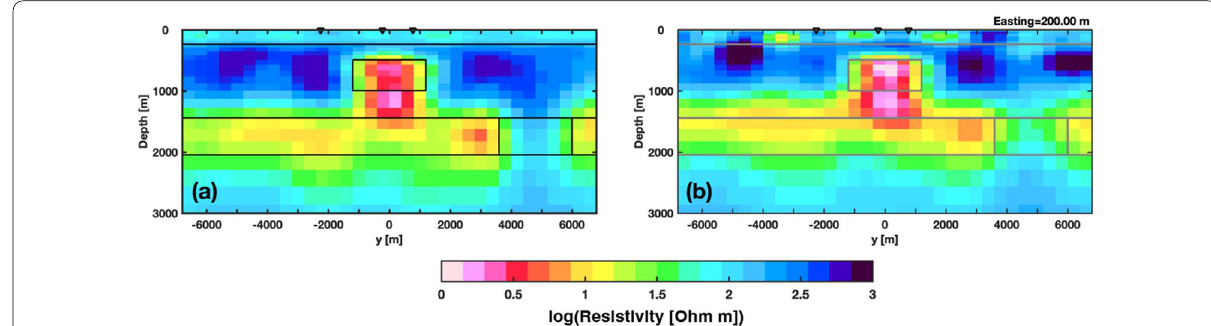
Fig. 30 NS cross sections at the easting of 200 m of the models inverted from a the synthetic model (Fig. 1) and b the synthetic model with near‑surface distorters (Fig. 20) using PT with a linear scale, where the initial/prior model is SSQ1D